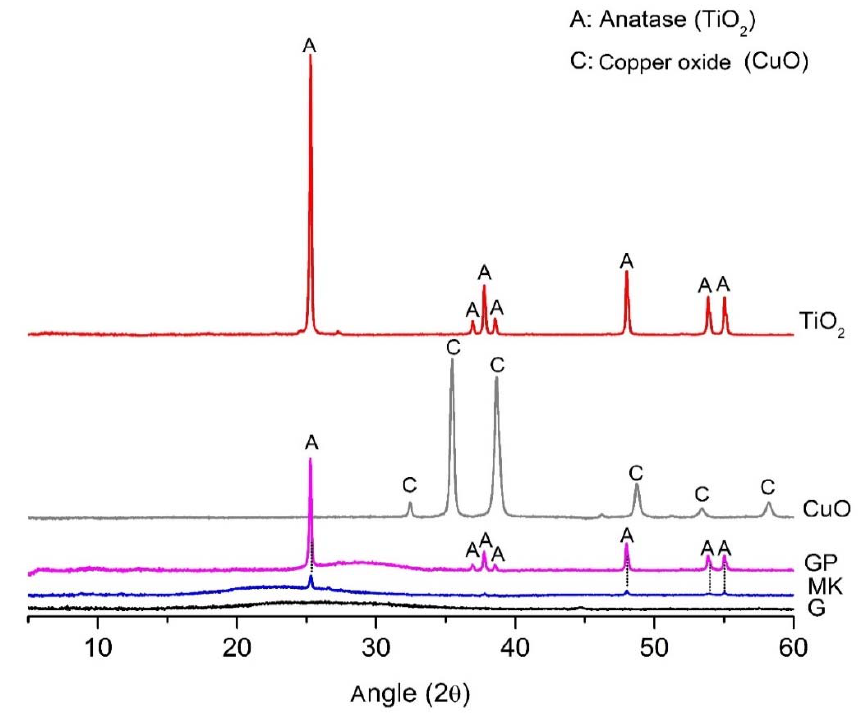
Figure 4. X-ray di ff raction (XRD) patterns of the raw materials and Figure 4. X ‐ ray diffraction (XRD) patterns of the raw materials and GP.